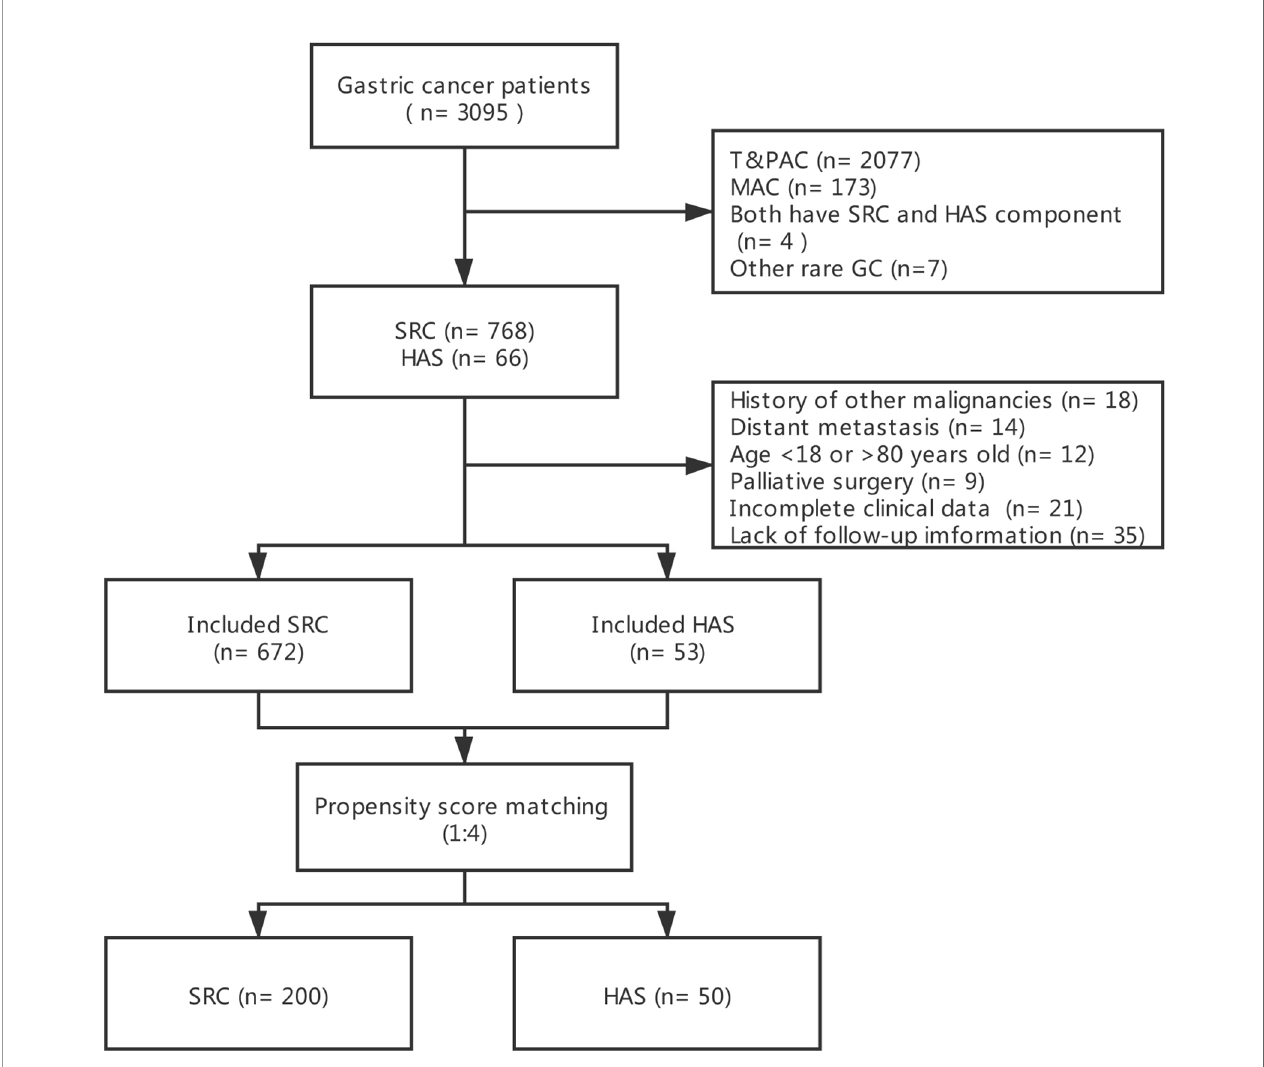
FIGURE 1 | Flow chart depicting the selection of the study